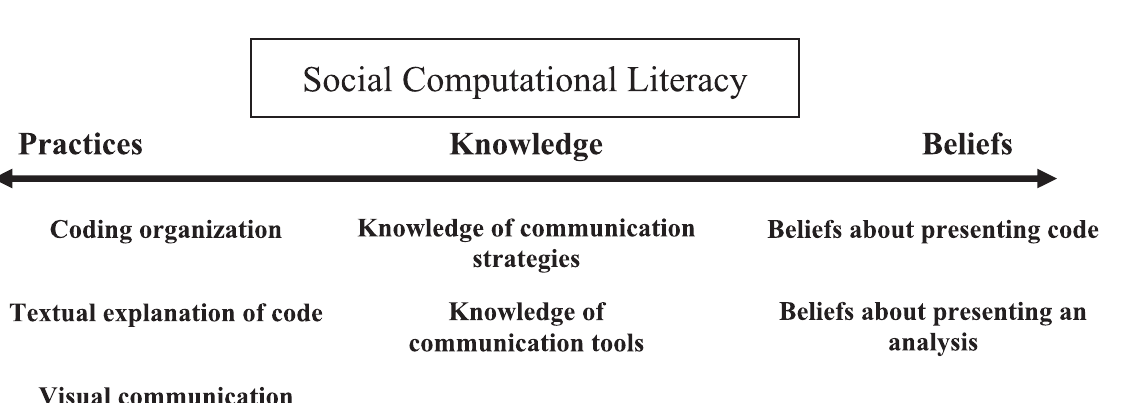
FIG. 3. Identified elements of material, cognitive, and social computational literacy in an undergraduate physics context. Elements are organized on a continuum ranging from concrete practices, to knowledge elements, to higher-level